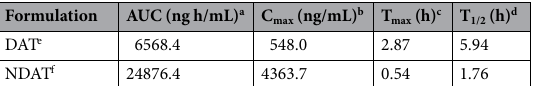
Table 1. Pharmacokinetic (PK) parameters of DAT and NDAT after s.c. injection into mice. a area under the concentration time curve; b maximum plasma concentration; c time taken to reach C max ; d overall elimination half-life (time for the drug concentration to reach half of its original value); e diamino tetraiodothyroacetic acid/ Cremophor EL micelles; f PLGA conjugated diamino tetraiodothyroacetic acid